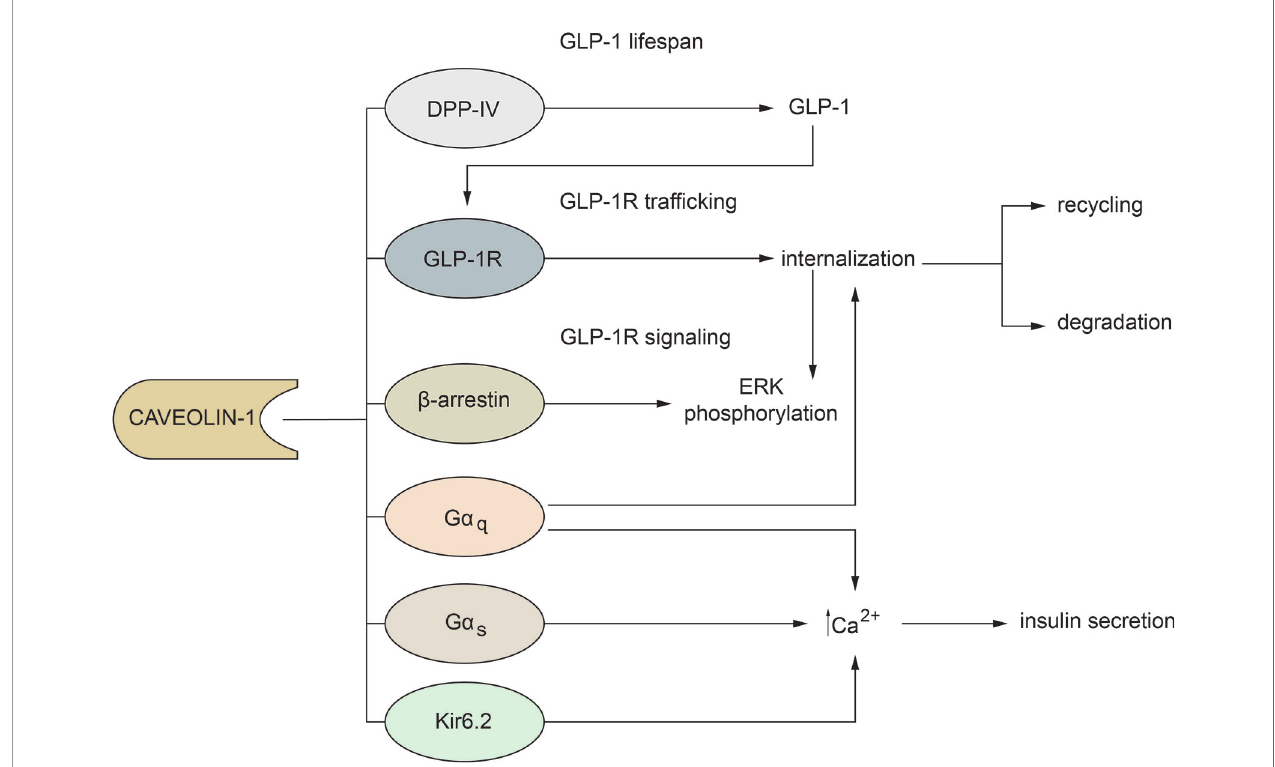
FIGURE 1 | Main mechanisms through which Cav-1 regulates GLP-1